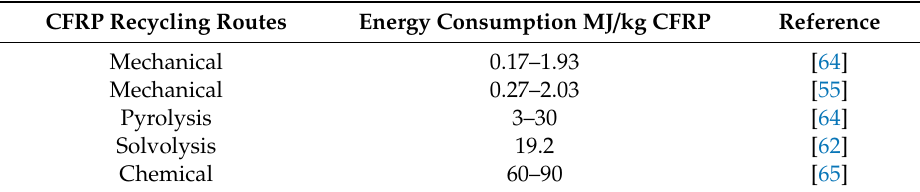
Table 1. Energy required (MJ) in order to recycle 1 kg carbon fibre reinforced polymer (CFRP) using di ff erent